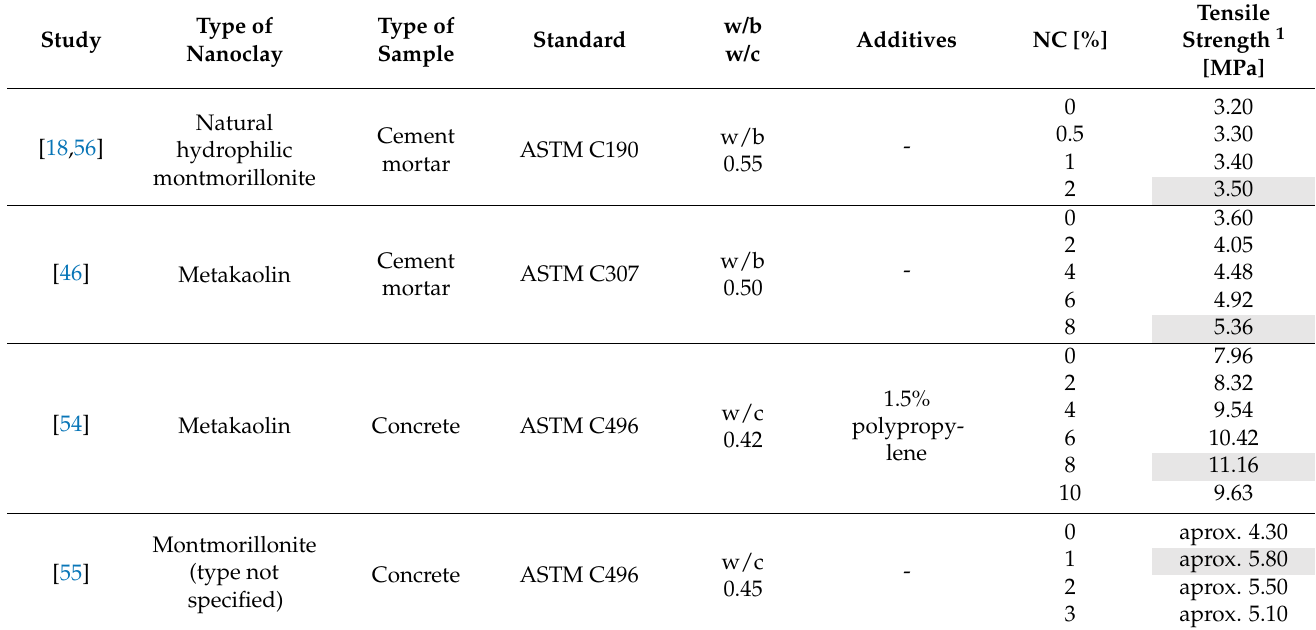
Table 1. Splitting tensile strength values for different nanoclay-cement matrix